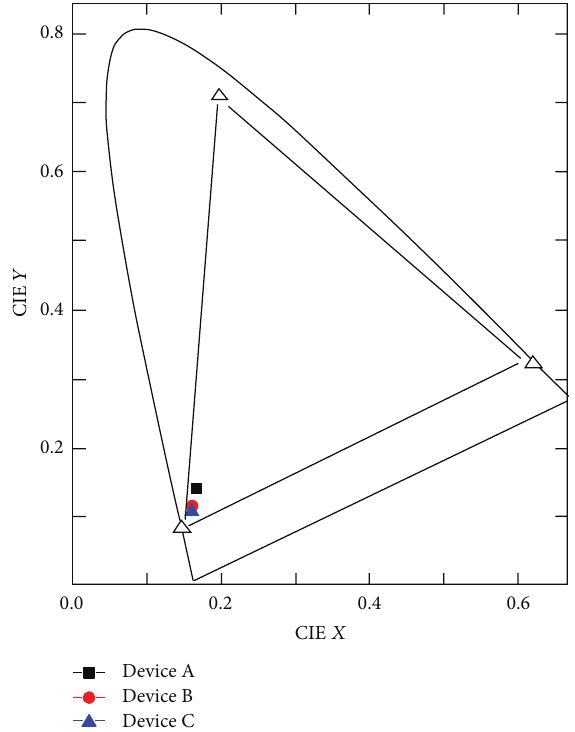
Figure 5: The CIE chromaticity coordinates of devices A–C at the applied voltage of 9